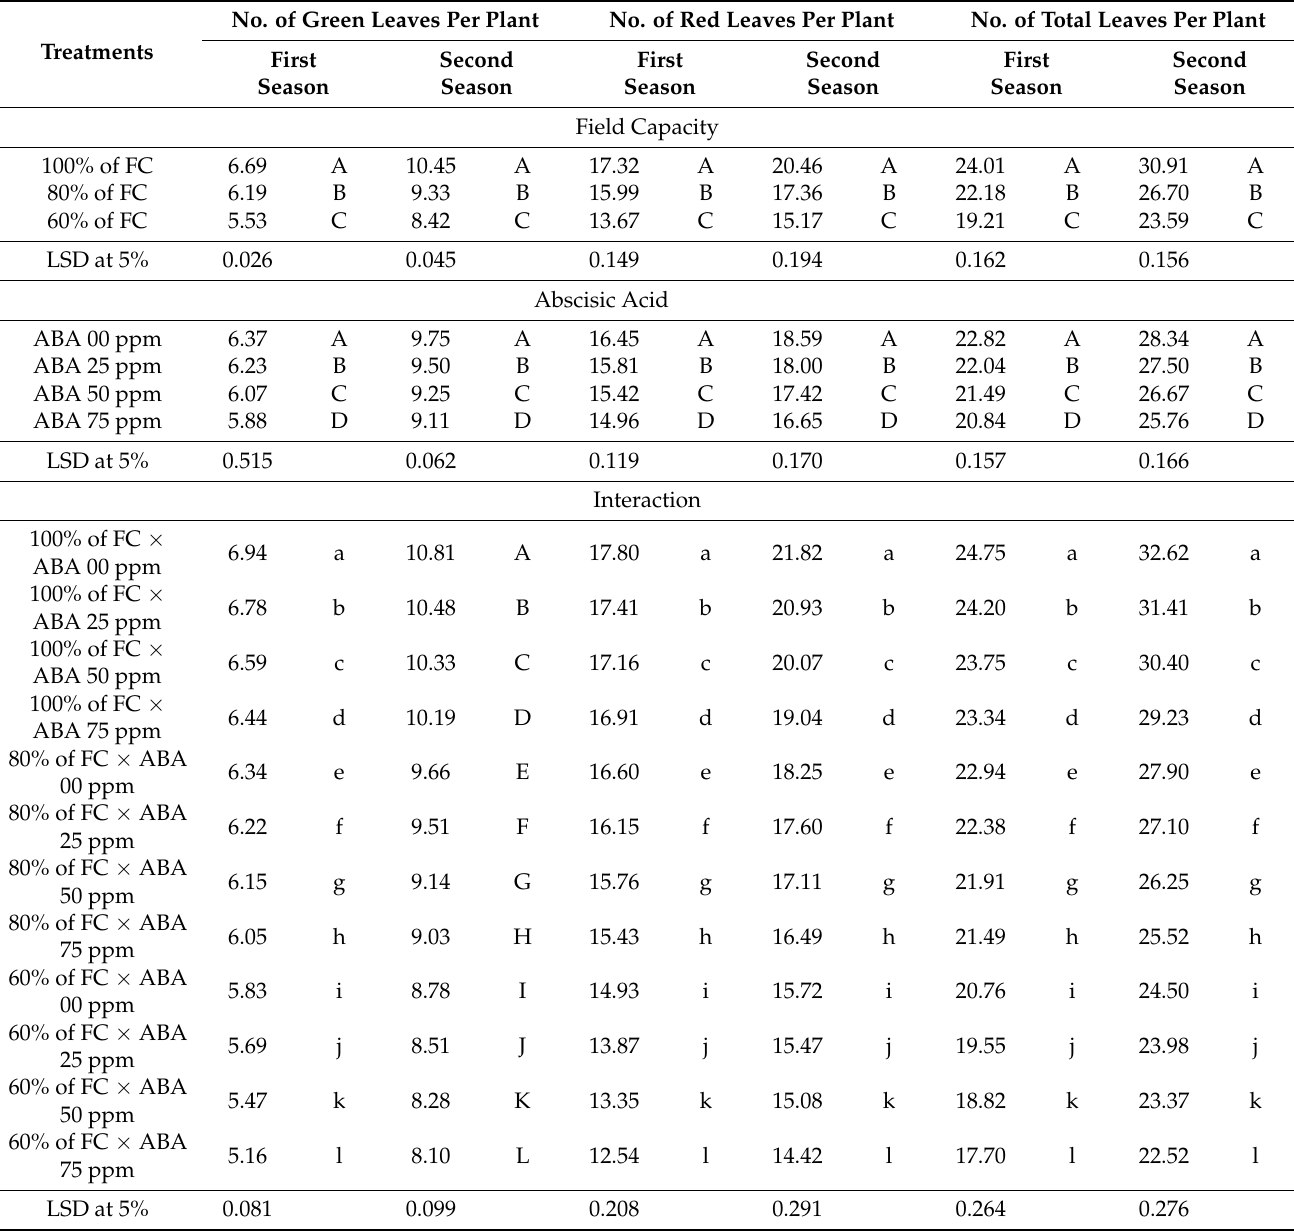
Table 4. Effect of water stress and abscisic acid on numbers of green leaves, numbers of red leaves, and total numbers of leaves per plant of red cabbage (2021–2022